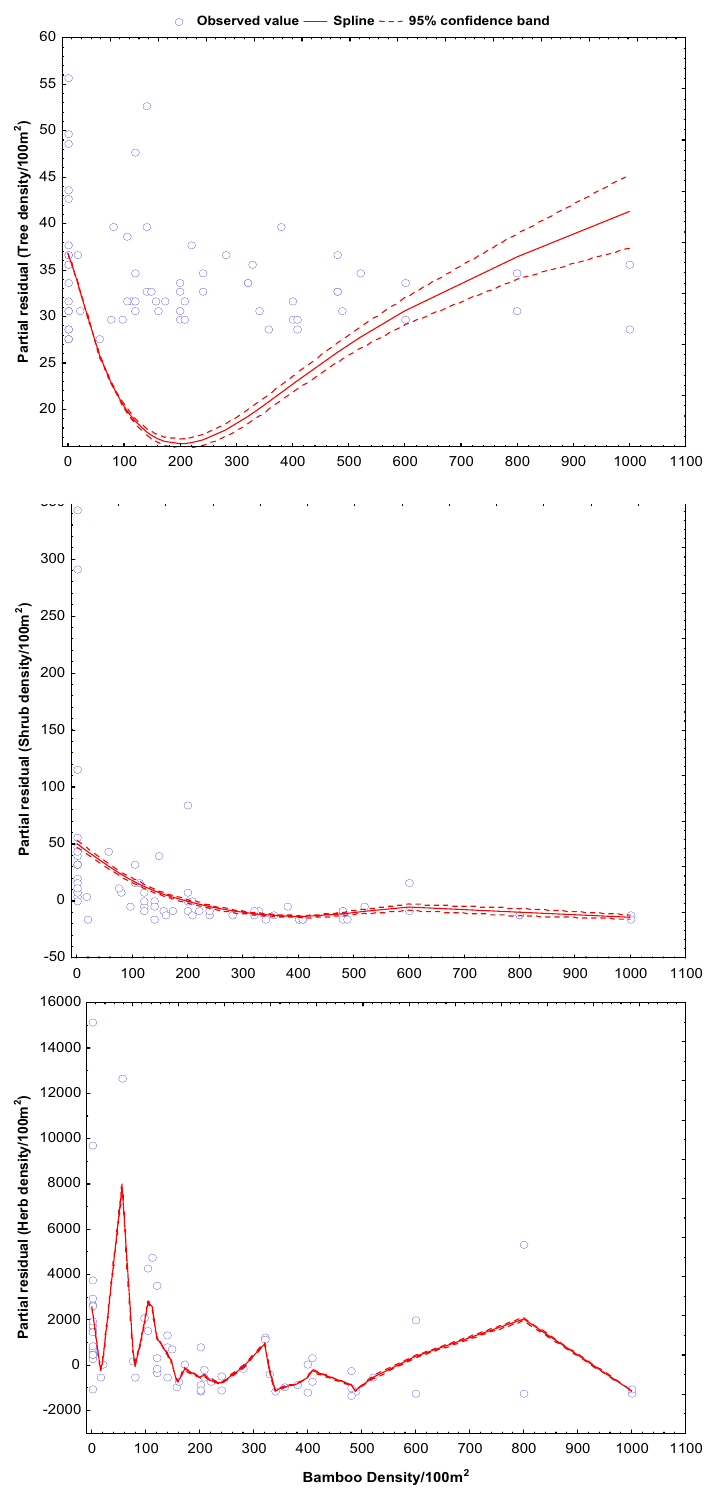
Figure 2. Predicted changes in density of trees, shrubs and herbs with respect to increasing density of bamboo. The significance of the smooth best fit model generalized the changing slope as GAM coefficient (β), standard error (SE) and coefficient of determinant (R 2